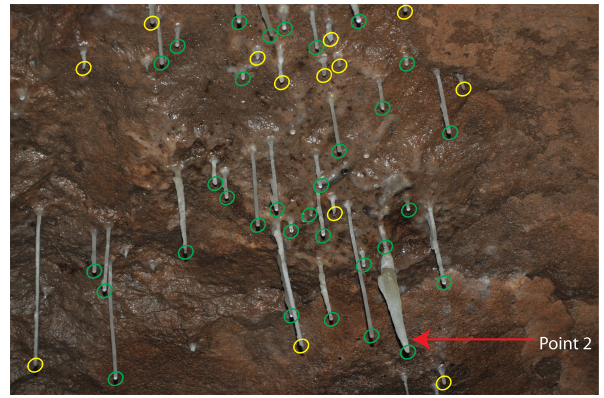
Figure 7. Actively dripping stalactite count. Green circles are sta- lactites identified as active in terms of dripping (displaying water droplets and/or white flash at their tip) and yellow ones are inactive. In this photo, 32 green circles and 13 yellow ones are